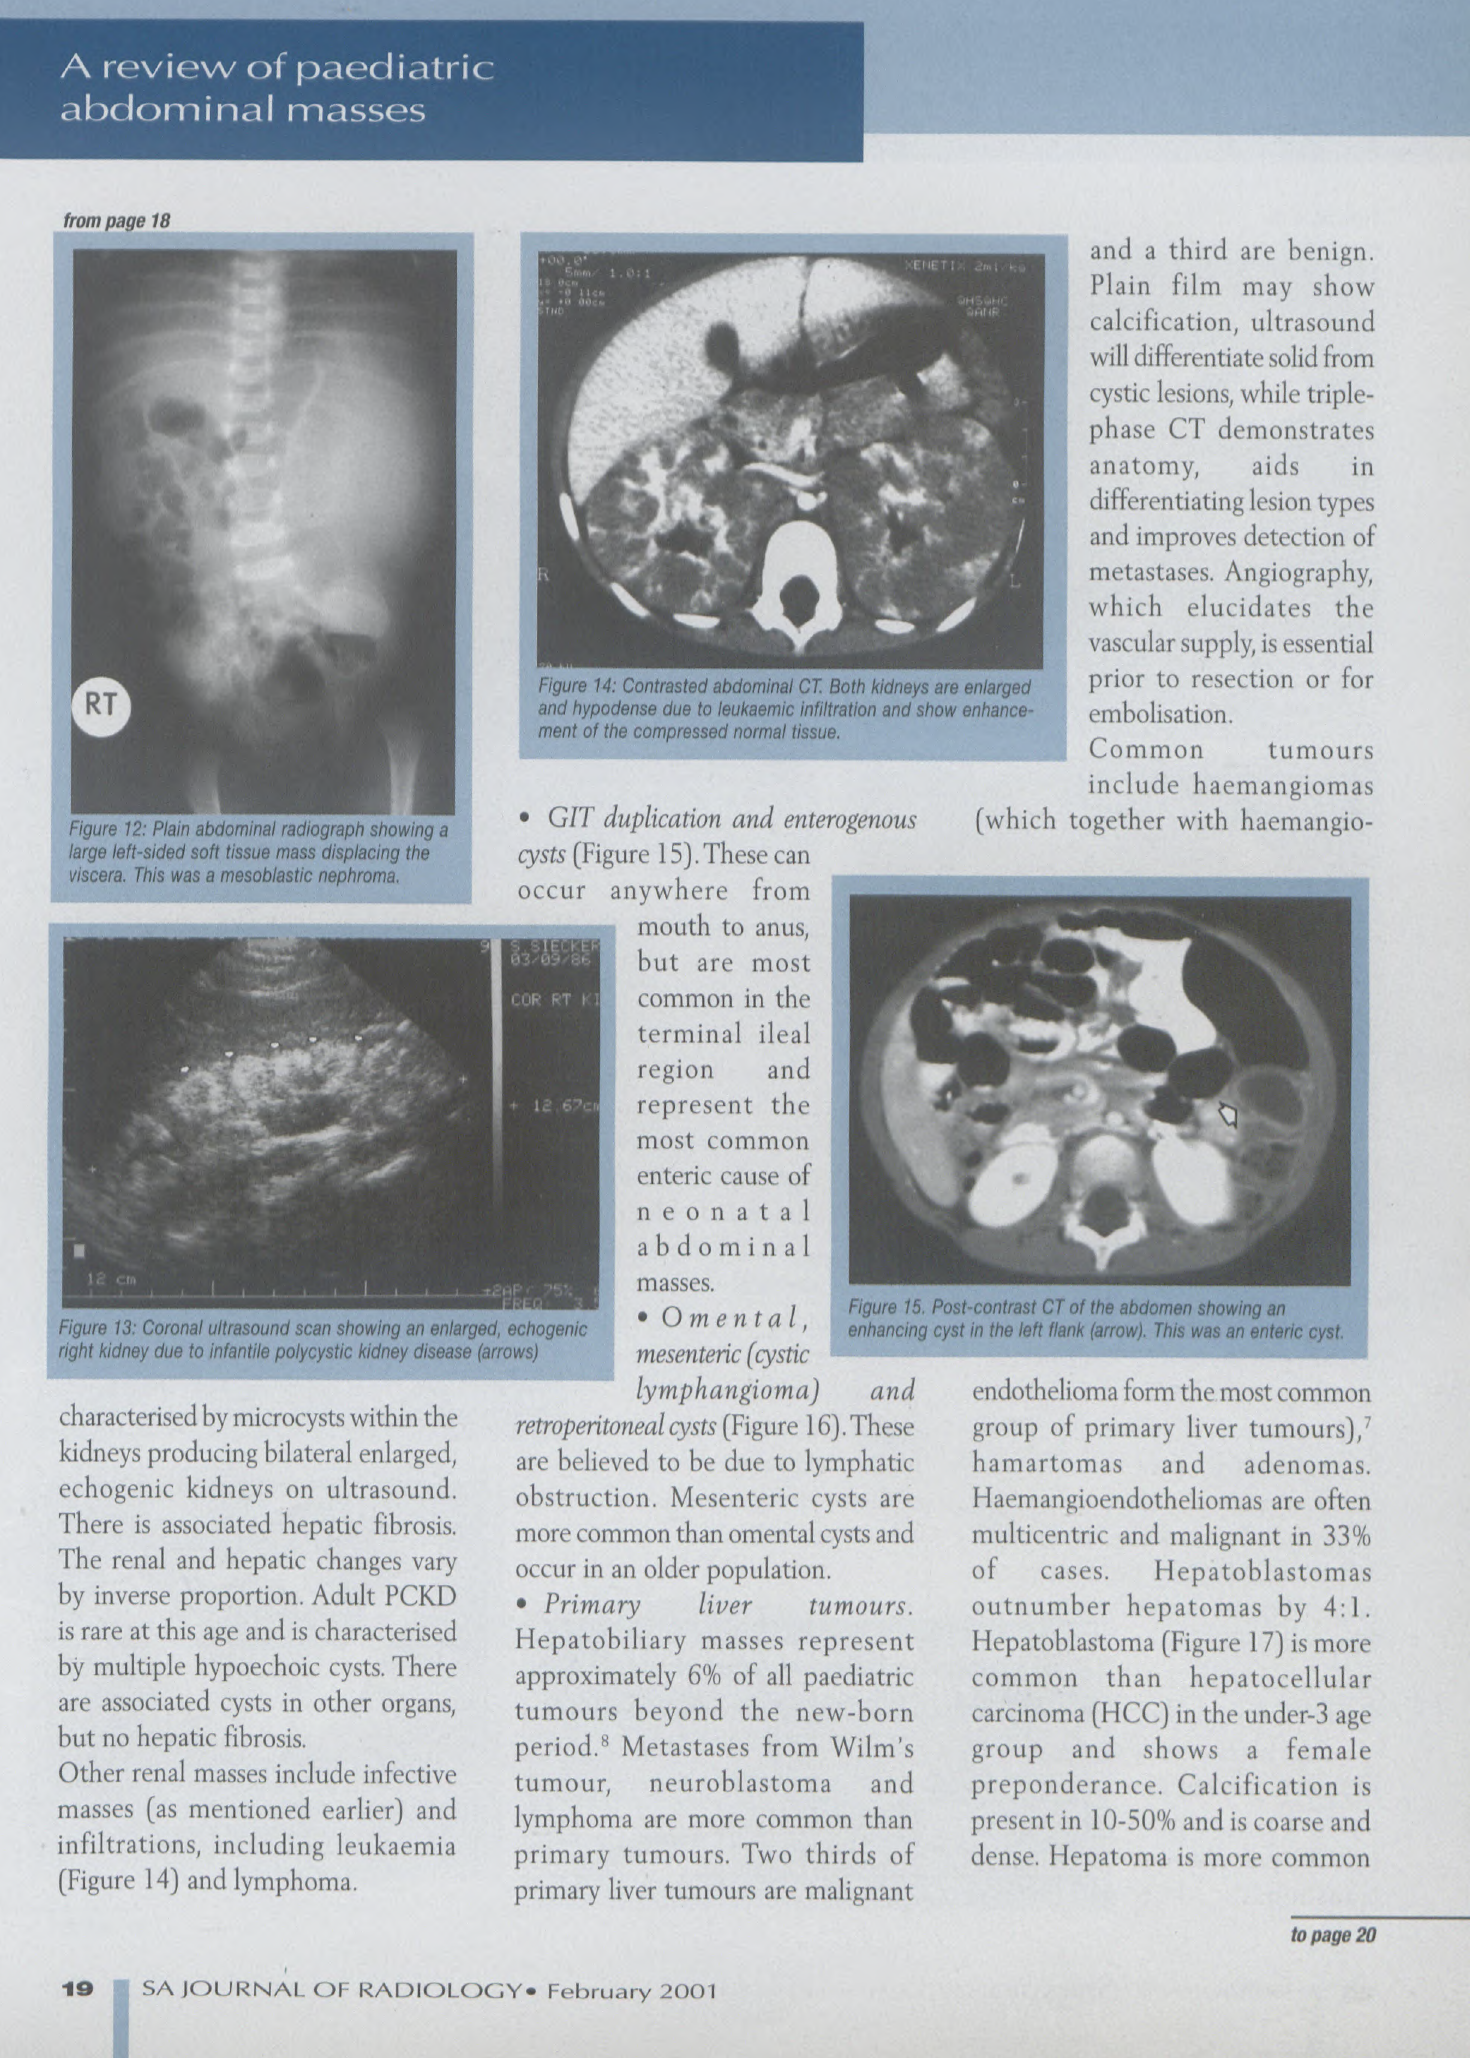
Figure 14: Contrasted abdominal CT. Both kidneys are enlarged and hypodense due to leukaemic infiltration and show enhance- ment of the compressed normal tissue.